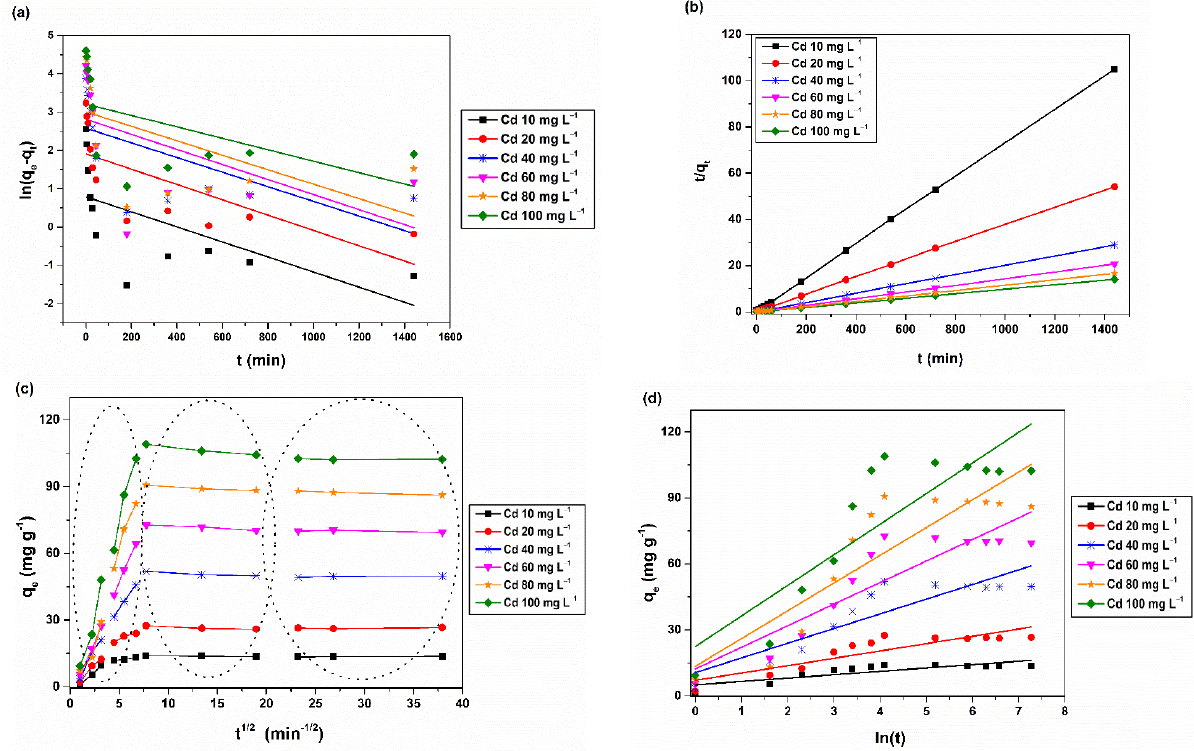
Figure 13. ( a ) Pseudo-first order, ( b ) pseudo-second order, ( c ) Weber–Morris intra-particle diffusion, and ( d ) Elovich kinetic models used to describe Cd adsorption on CHIT-PAAA.